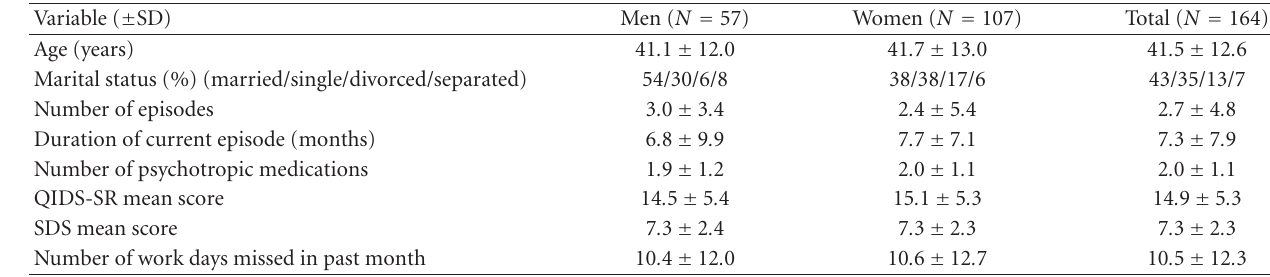
Table 1: Demographic and assessment data on patients ( N = 164) with major depressive